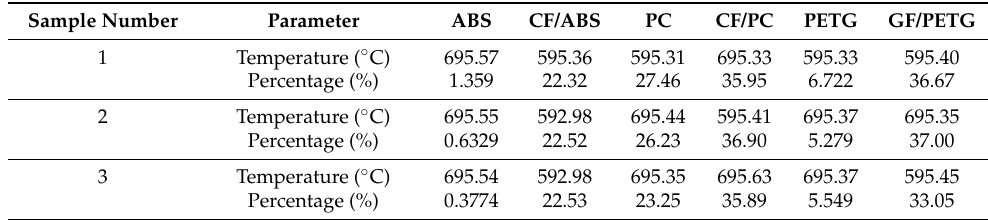
Table A6. TGA T deg from